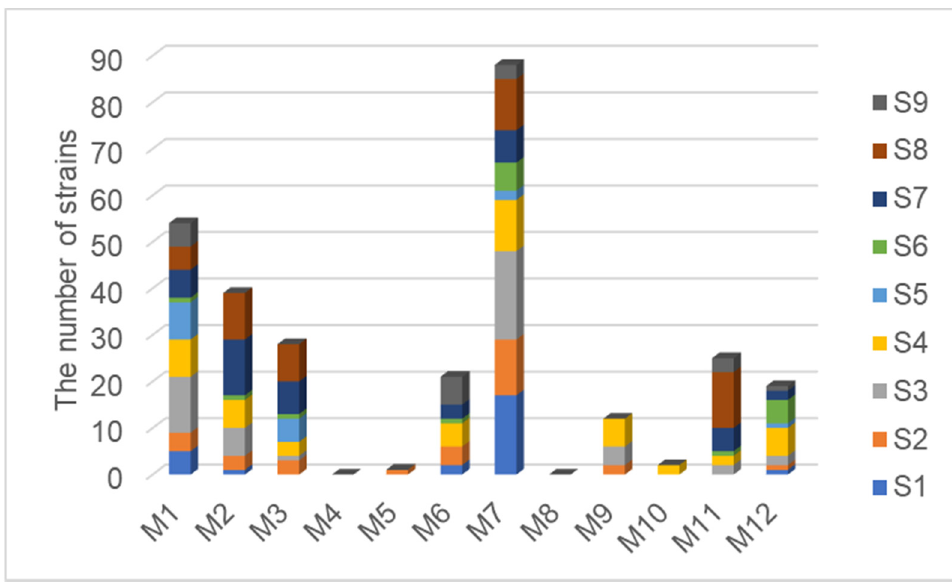
Figure 3. Comparison of endophytic bacteria isolation by different